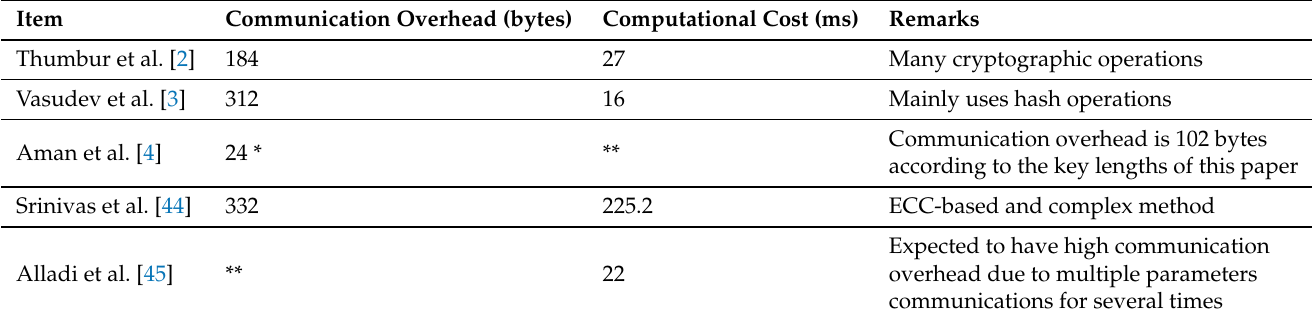
Table 8. Performance